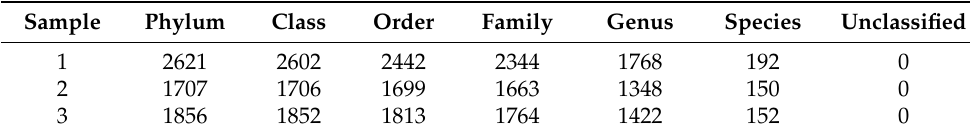
Figure 5. OTU Venn diagram. Each circle represents a sample; the overlap between the circles indicates the common OTUs between the samples, and the number of each block indicates the number of common or unique OTUs of the samples contained in the block. Table 3. The number of OTU divisions for different classification